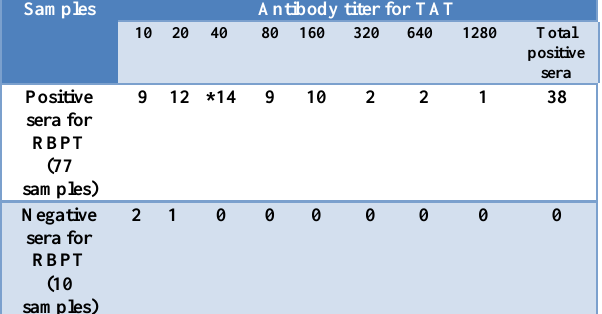
Table, 4: Rate of infection of sheep brucellosis by using TAT for positive and negative sera with